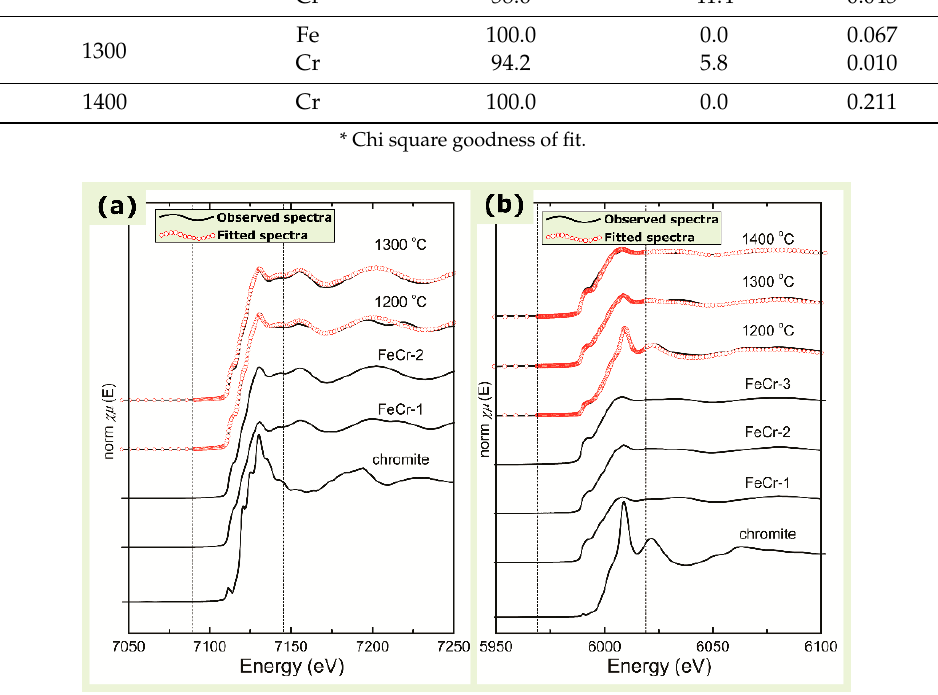
Figure 9. ( a ) Normalized Fe K-edge spectra of the products formed at 1200 and 1300 °C. Vertical dotted lines show the fitting range (i.e., 7092–7142 eV). Reference spectra used in least-squares fitting are shown for chromite (ore) and two Ring of Fire ferrochrome samples (FeCr-1 and FeCr-2); ( b ) Normalized Cr K-edge spectra of the products formed at 1200, 1300 and 1400 °C. The fitting range of 5970–6020 eV is marked by vertical dotted lines. Also shown are the spectra of the relevant model or reference compounds (chromite represents the starting ore material; FeCr-3 represents Cr 3 C 2 ).